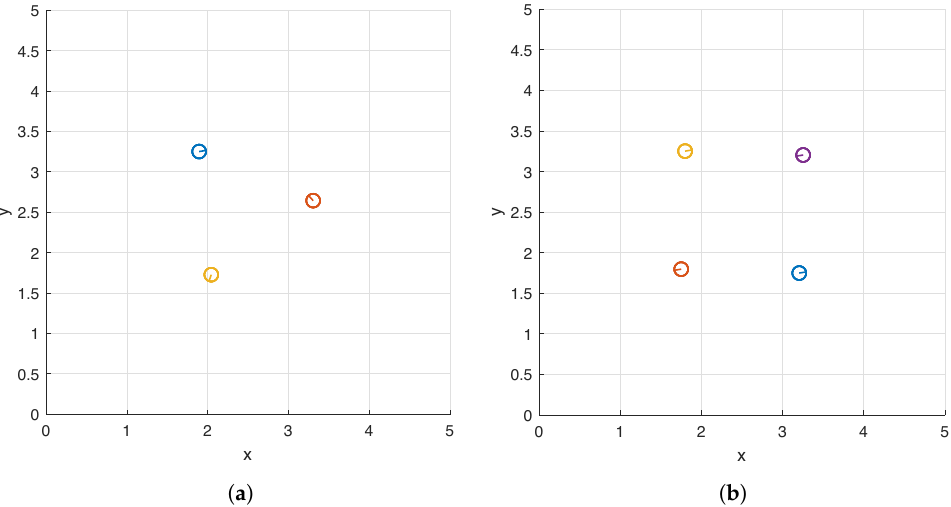
Figure 10. The top views of the optimal carpets consisting of three ( a ) and four ( b ) helices found by the hybrid method. The flow meter is (7) with W =